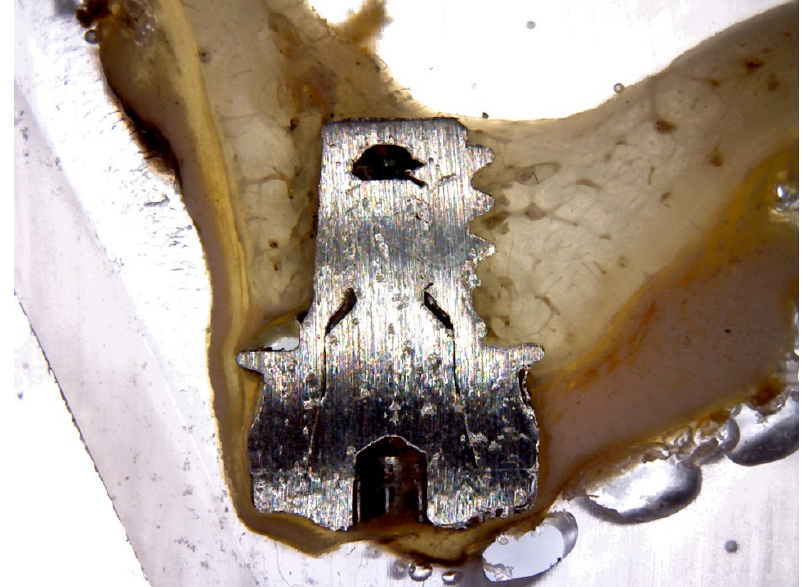
Figure 5. After polymerization, the specimens were sectioned along their longitudinal axis with a high precision diamond disk, at about 150 to 30 μm.